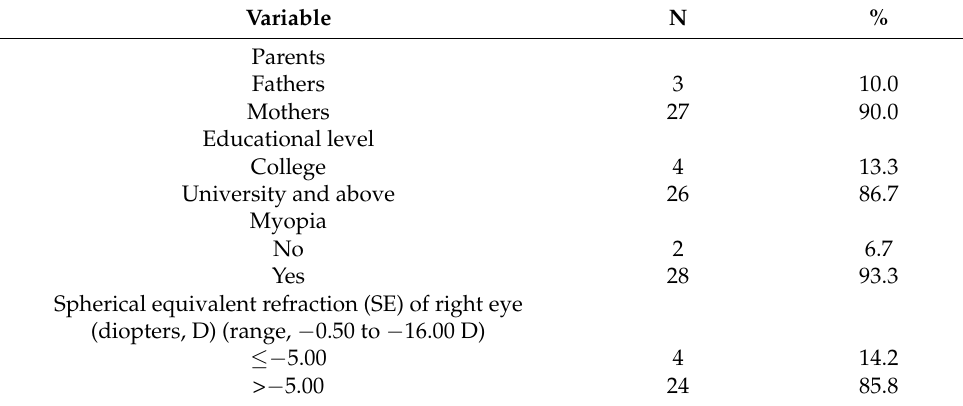
Table 3. Demographic information of